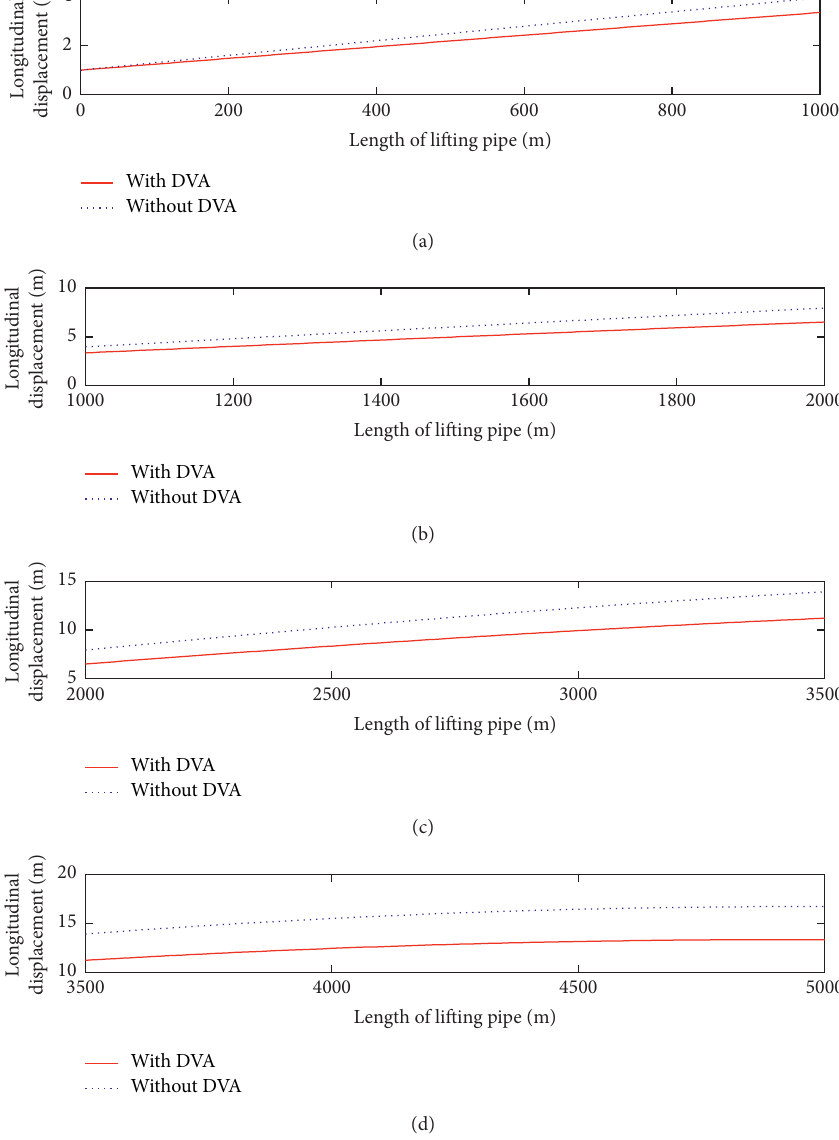
Figure 11: Comparison of the lifting pipe’s longitudinal vibration with and without DVA. (a) x :0 ⟶ 1000m. (b) x :1000 ⟶ 2000m. (c) x : 2000 ⟶ 3500m. (d) x : 3500 ⟶